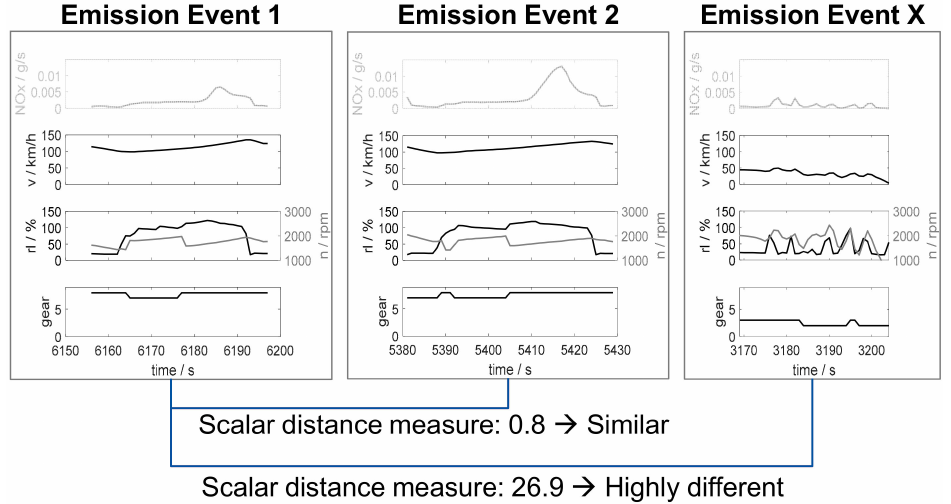
Figure 4. Comparing different events using a dynamic time warping approach with selected reference signals to calculate a scalar distance